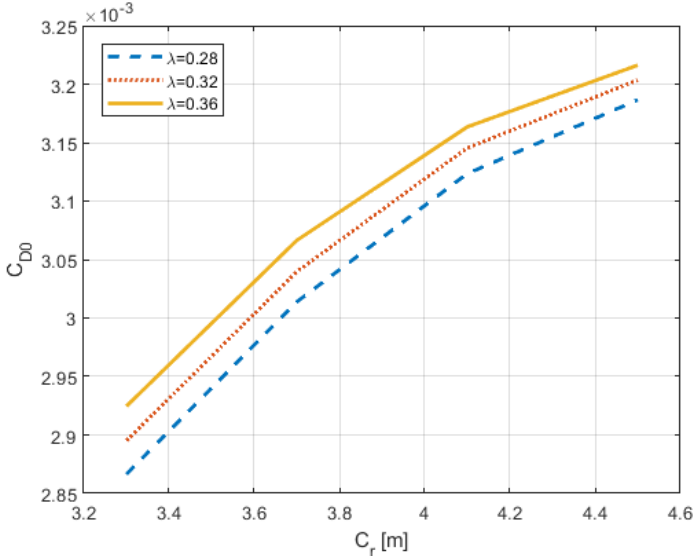
Figure 7. Friction drag coefficient as a function of the taper ratio and root chord along the new feasible design space determined intersecting the active